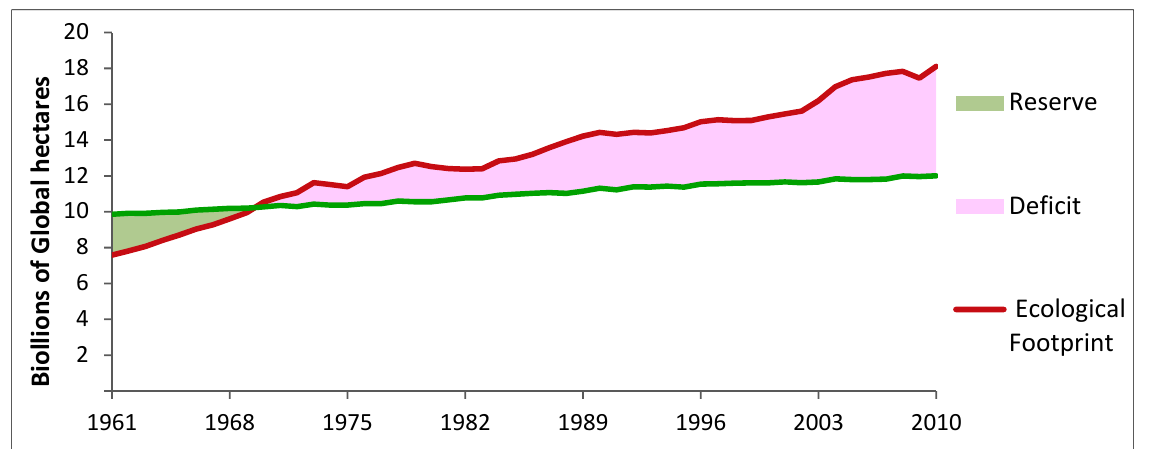
Figure 1. Global Ecological Footprint and biocapacity